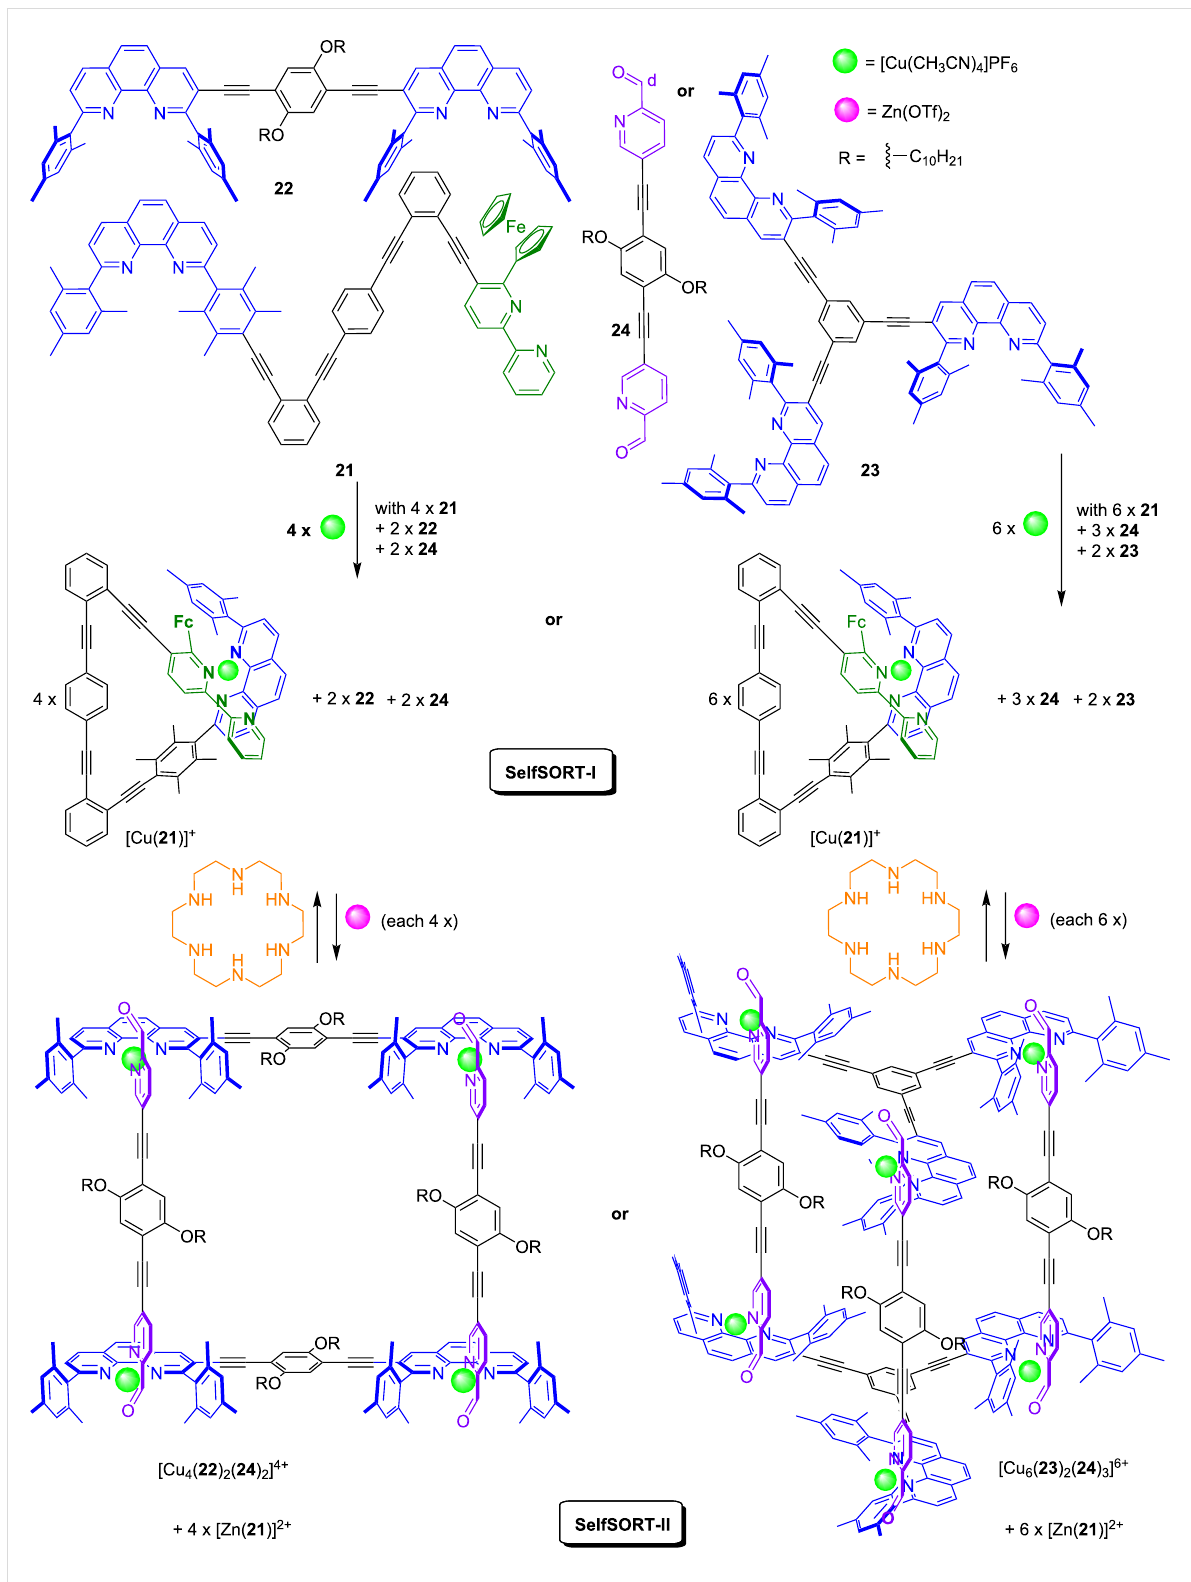
Figure 10: Communication between the nanoswitch 21 and the supramolecular assemblies [Cu 4 ( 22 ) 2 ( 24 ) 2 ] 4+ or [Cu 6 ( 23 ) 2 ( 24 ) 3 ] 6+ was guided by a double